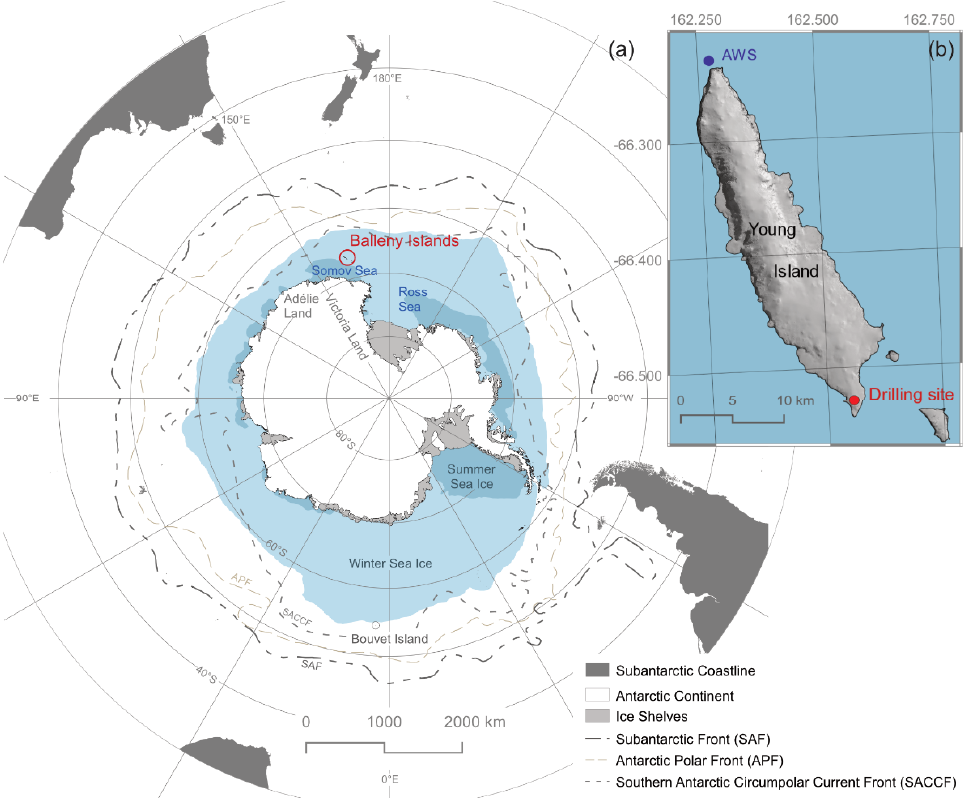
Figure 1. Map of ( a ) the Antarctic including the Balleny Island study area, the September (light blue) and February (dark blue shading) sea ice extent for the long-term median period 1981–2010 (NSIDC); Subantarctic Front (SAF, outermost anthracite dashed line), Antarctic Polar Front (APF, middle light-grey dashed line), and Southern Antarctic Circumpolar Current Front (SACCF, innermost grey-dashed line) given; ( b ) detailed map of Young Island with red and blue marker indicating ice core drilling and automatic weather station (AWS) sites, respectively.